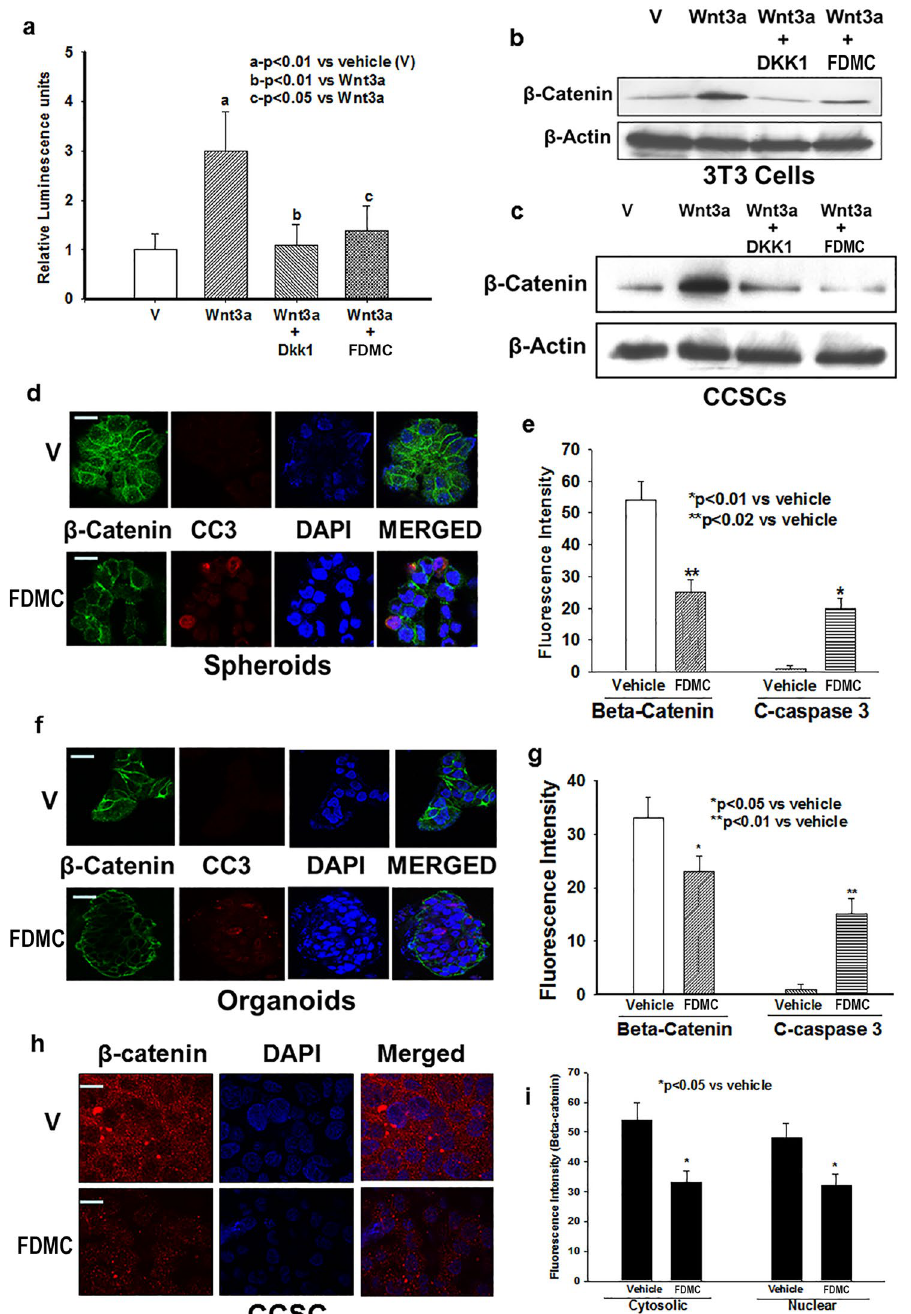
Figure 5. Effects of FDMC on Wnt/β-catenin activity in CCSCs, spheroids and organoids, and induction of apoptosis, as evidenced by comparisons with vehicle-treated controls (V = vehicle). ( a ) Wnt receptor activity (luciferase units) significantly induced by agonist (Wnt3a) ( a p < 0.01) and decreased by antagonist (DKK1) ( b p < 0.01) in 3T3 cells. FDMC (50 µM) treatment for 24 h significantly suppressed agonist-induced receptor activity ( c p < 0.01) in 3T3 cells. ( b ) Western blot data show that Wnt receptor agonist Wnt3a treatment induced β-catenin expression, whereas Wnt receptor antagonist DKK1 treatment abolished the Wnt3a-induced induction of β-catenin in 3T3 cells. FDMC inhibited Wnt3a-induced β-catenin expression in 3T3 cells. ( c ) Western blot data show that Wnt receptor agonist Wnt3a treatment induced β-catenin expression, whereas Wnt receptor antagonist DKK1 treatment abolished the Wnt3a-induced induction of β-catenin in CCSCs. FDMC inhibited Wnt3a-induced β-catenin expression in CCSCs. ( d , e ) Confocal microscopy data show that FDMC (50 µM) treatment to CCSC-derived spheroids significantly depleted β-catenin expression (green immunofluorescence staining) and induced apoptosis (cleaved caspase 3; red immunofluorescence staining; * p < 0.01 and ** p < 0.02). ( f , g ) Confocal microscopy data show that FDMC (50 µM) treatment to CCSC-derived organoids significantly depleted β-catenin expression (green immunofluorescence staining) and induced apoptosis (cleaved caspase 3; red immunofluorescence staining; * p < 0.05 and ** p < 0.01). Results are mean ± SEM (bars; n =